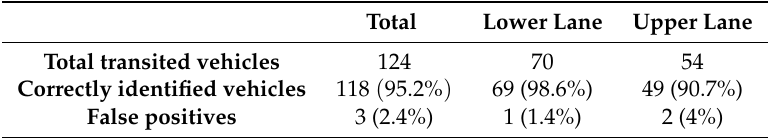
Table 3. Classification performance of the traffic flow monitoring.